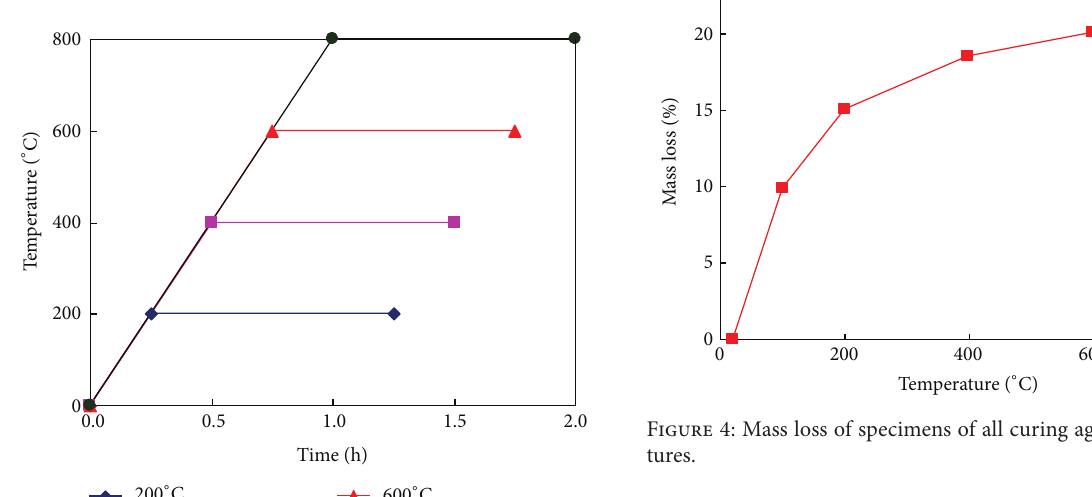
Figure 1: Typical tensile stress-strain response of ECC at 28 days.